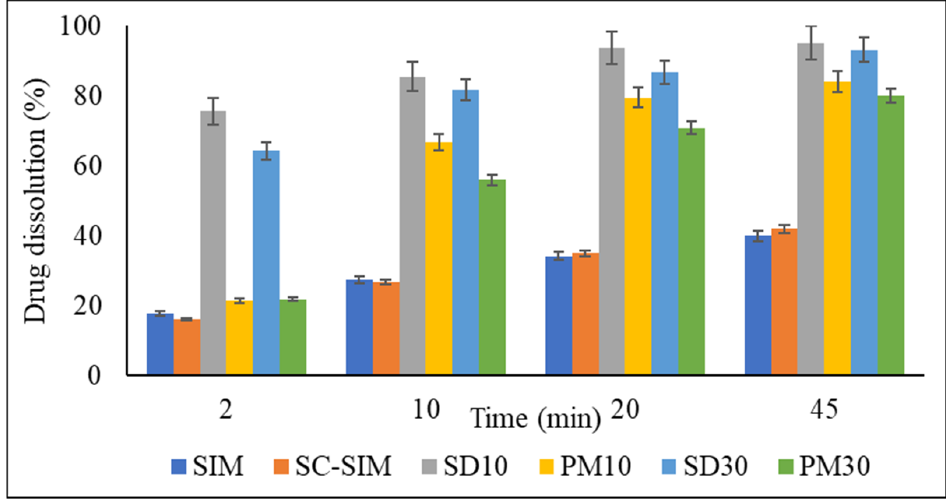
Figure 6. Dissolution profiles of bulk SIM, PMs, and SDs at 37 °C in pH 7 phosphate buffer containing 0.2% w/v SDS ( n = 3).